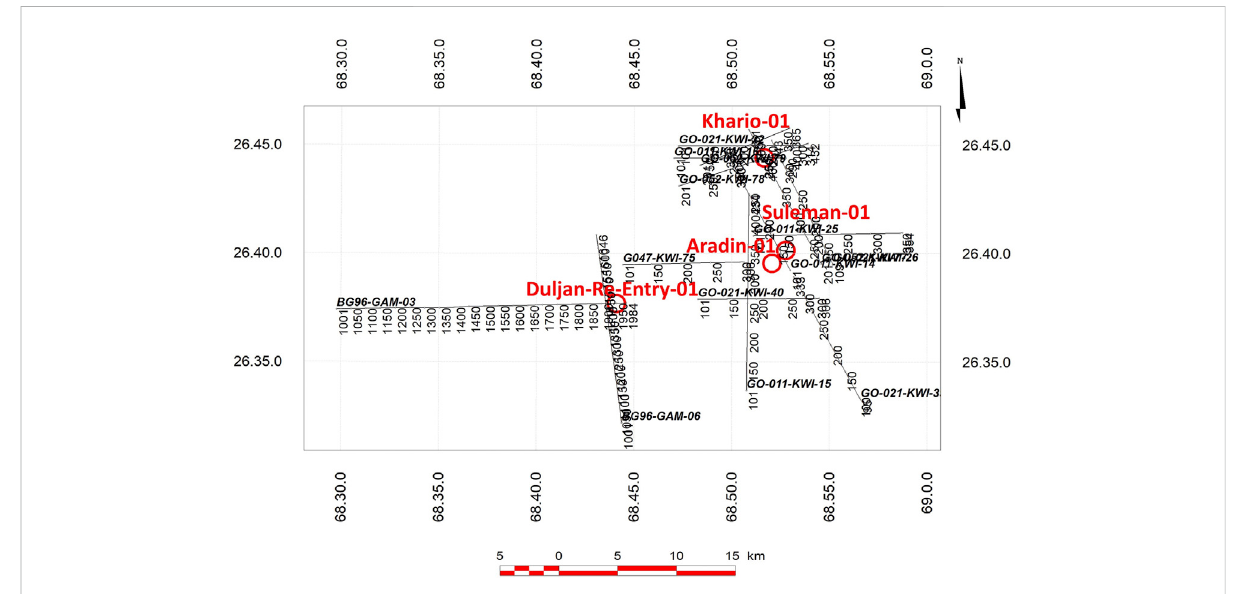
FIGURE 3 Seismic and well base map of the Khewari and Gambat areas.